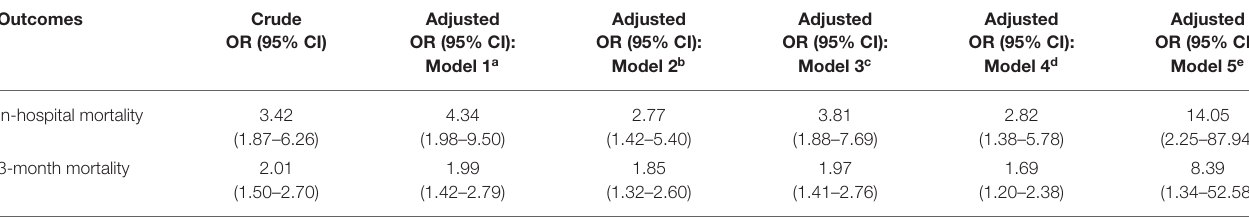
TABLE 3 | Associations between serum maximum chloride level and in-hospital and 3-month mortality. Outcomes